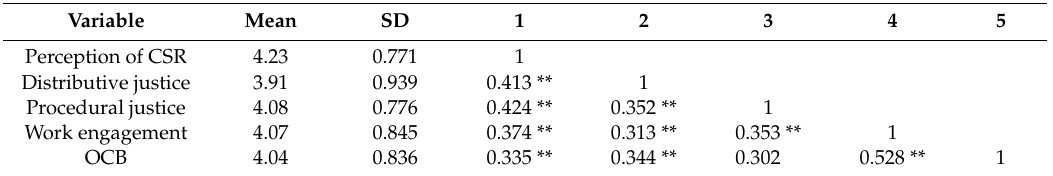
Table 2. Means standard deviation (SD) and correlation.